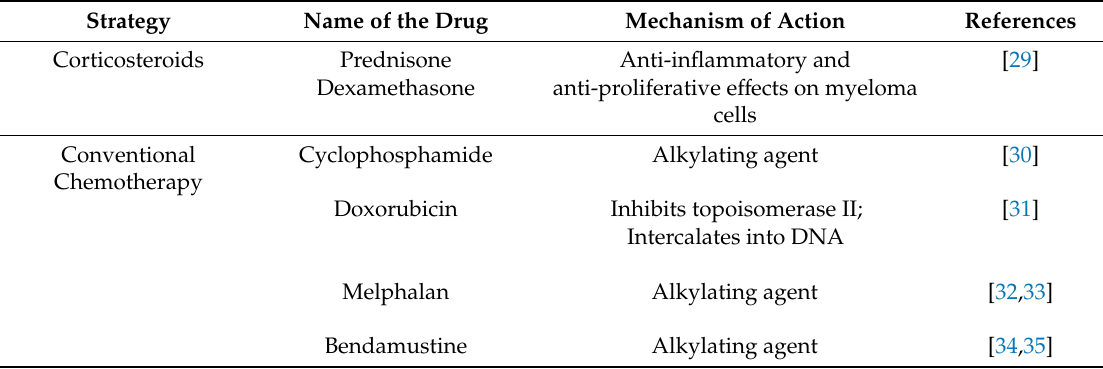
Table 1. Current Therapeutic Considerations for Multiple